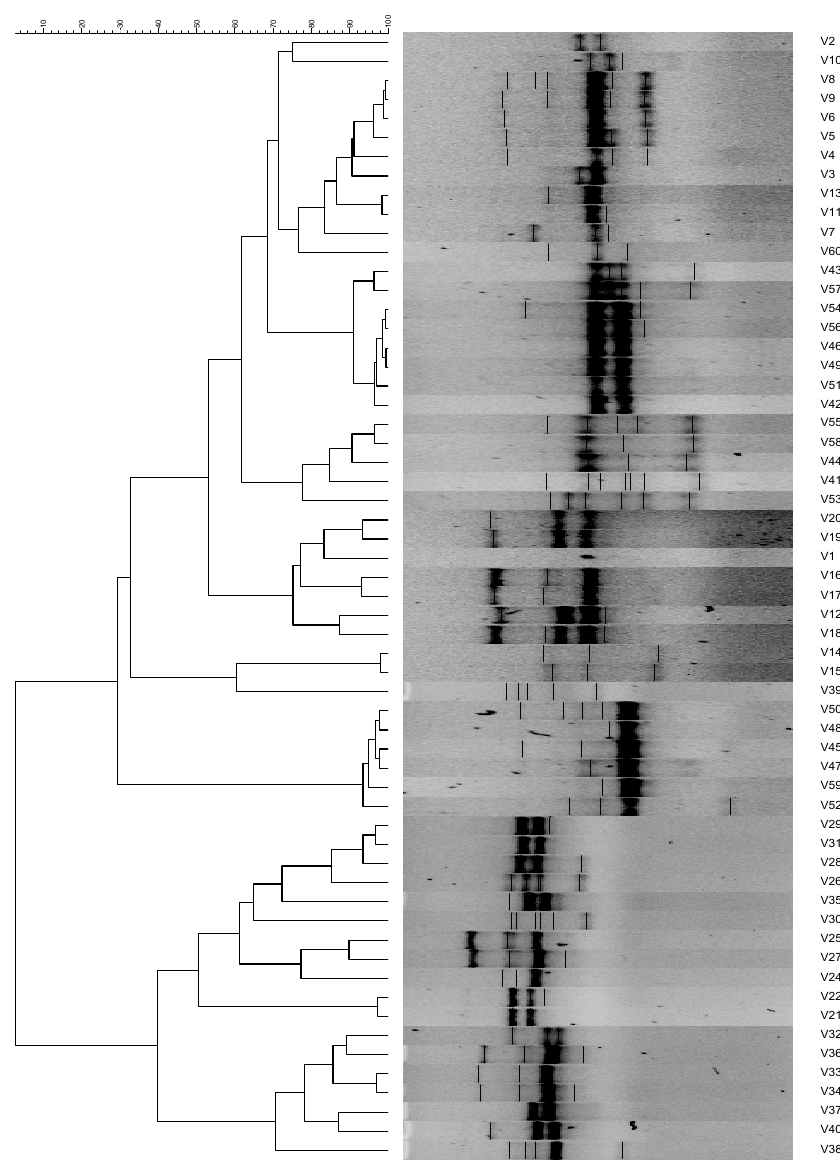
Figure 5. Phylogenetic tree of Vibrio vulnificus isolates (1–60) from RAPD analysis using primer RAPD15, which is able to differentiate into six clusters and three single isolates at an 80% similarity level.